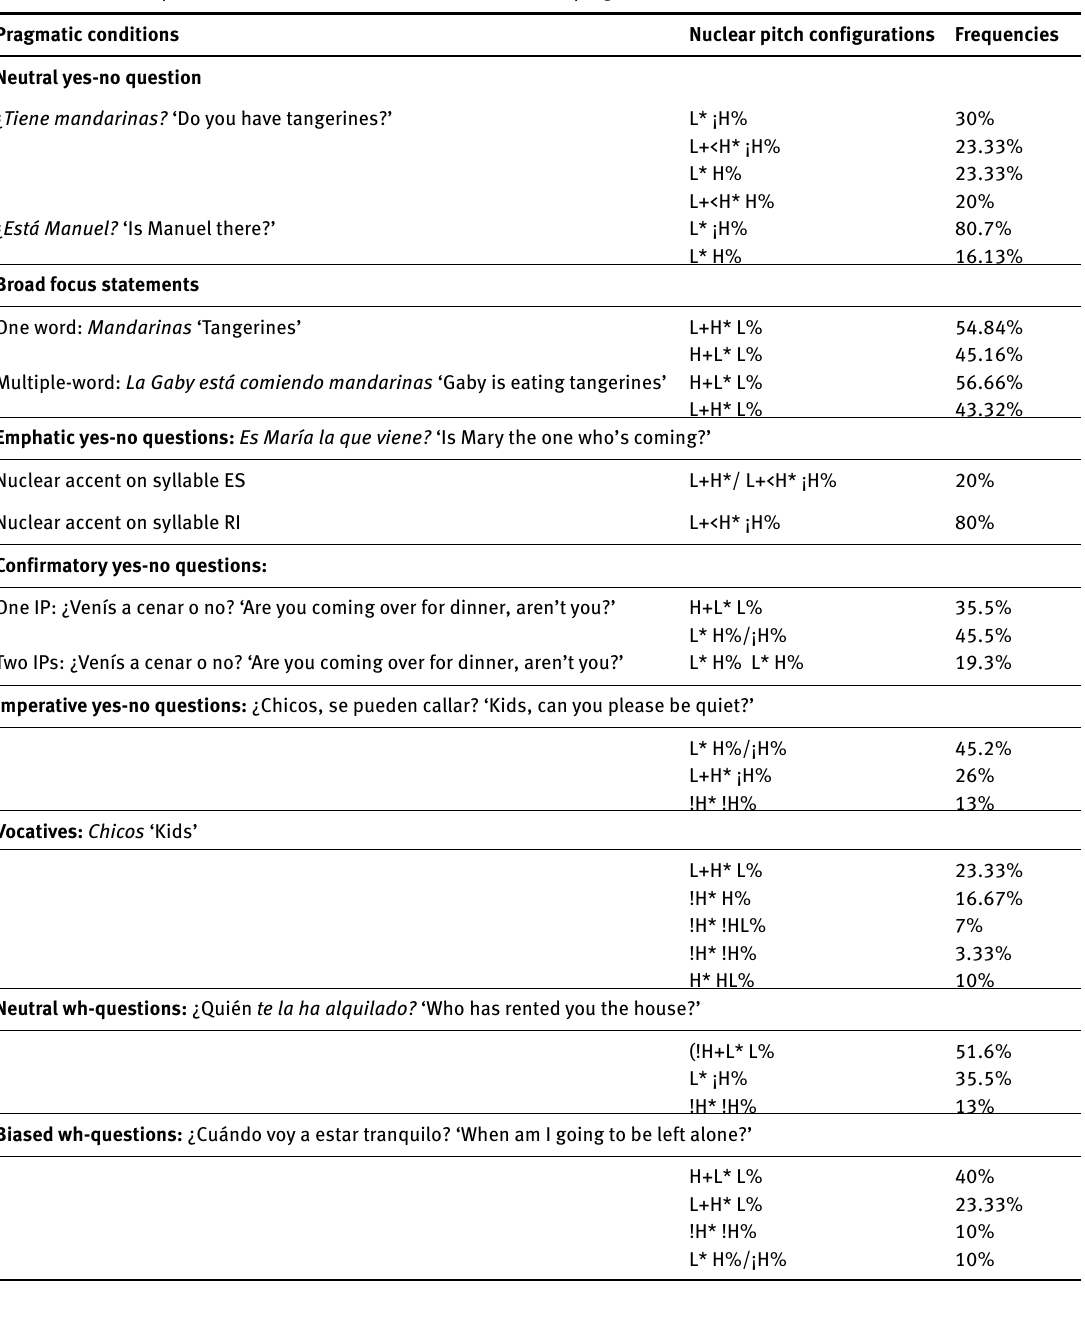
Table 2. Overall frequencies of the main intonation contours across pragmatic